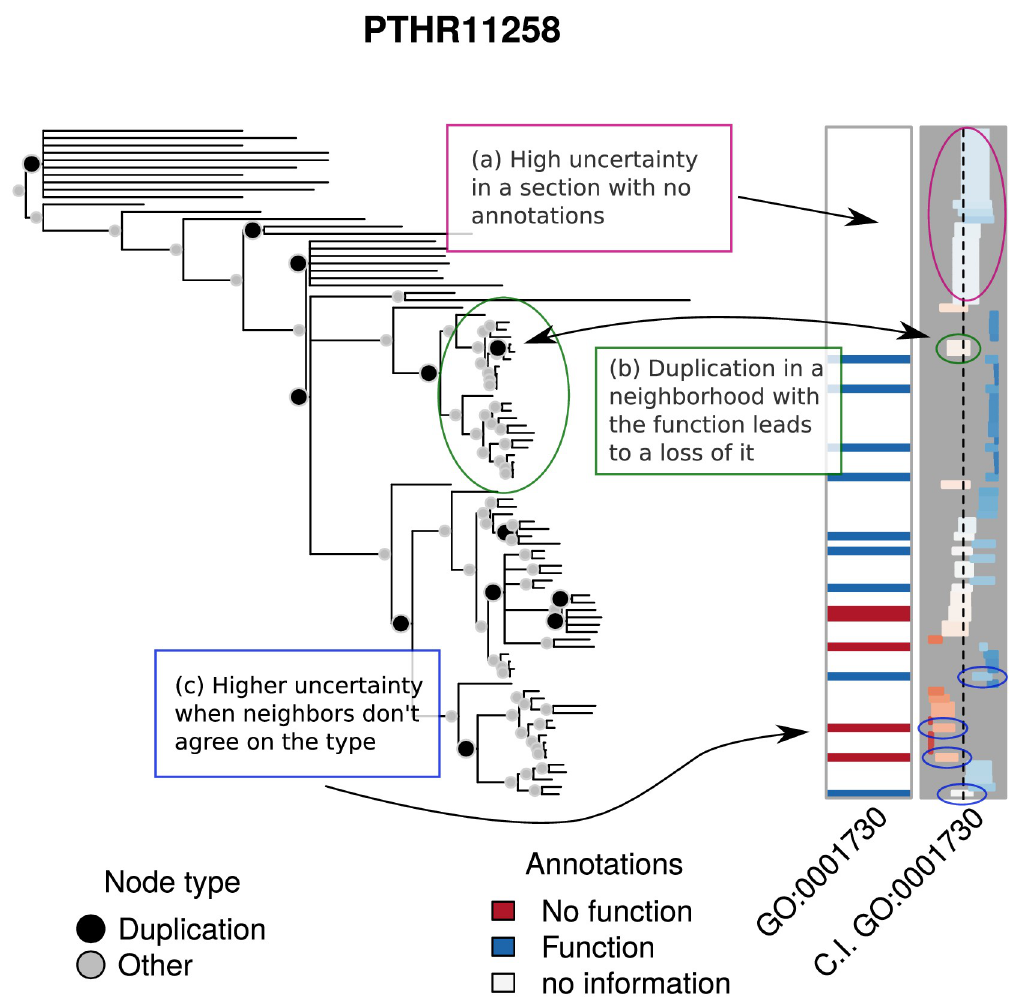
Fig 6. Low MAE predictions. The first set of annotations, first column, shows the experimental annotations of the term GO:0001730 for PTHR11258. The second column shows the 95% C.I. of the predicted annotations. The column ranges from 0 (left end) to 1 (right-end). Bars closer to the left are colored red to indicate that lack of function is suggested, while bars closer to the right are colored blue to indicate function is suggested. Depth of color corresponds to strength of inference. The AUC for this analysis is 0.91 and the Mean Absolute Error is